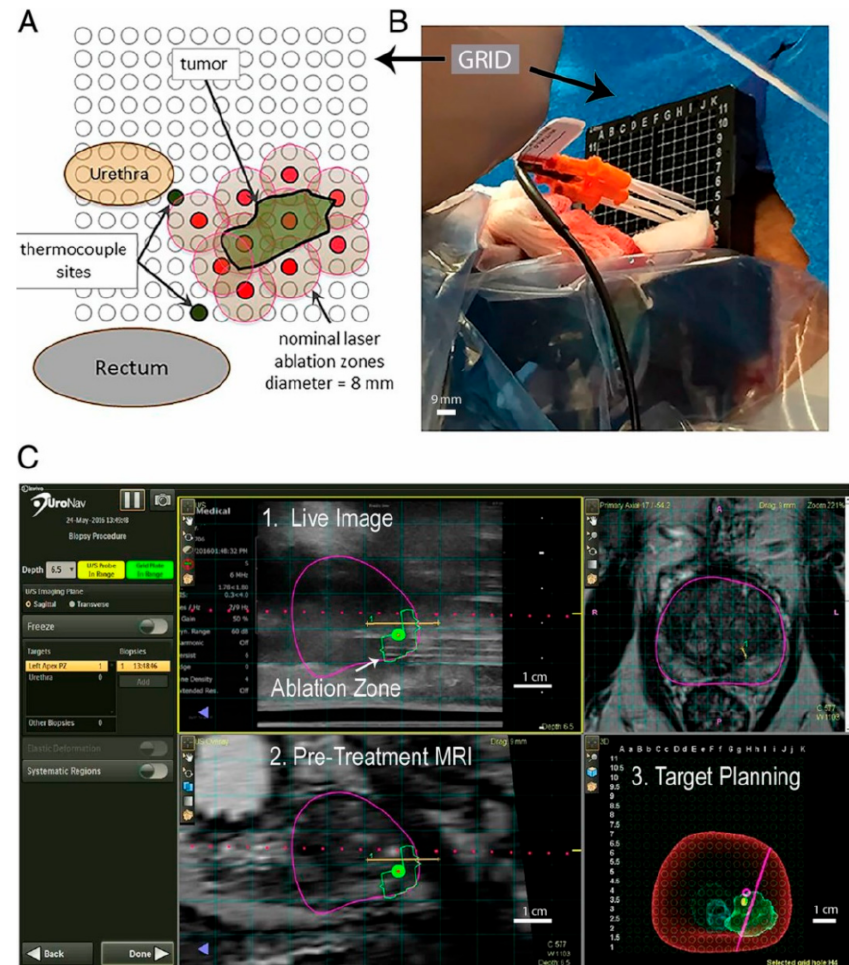
Figure 3. Photothermal treatment applied to a prostate tumor using the transperineal approach. ( A ) Axial view of the prostate ablation zone and the adjacent urethra and rectum overlaid with a rectangular transperineal grid (3-mm spacing). The introducer trocars (red) penetrated the ablation zone through the targeting grid, allowing for the 4 to 5 mm treatment radius (tan). ( B ) Laser introduc- ers (orange hub) placed with the thermocouple (black) through the transperineal grid. ( C ) UroNav MR/US Fusion guidance for trocar placement with real-time ultrasound imaging (Scale bar: B, 9 mm; C, 1 cm). Adapted with permission from